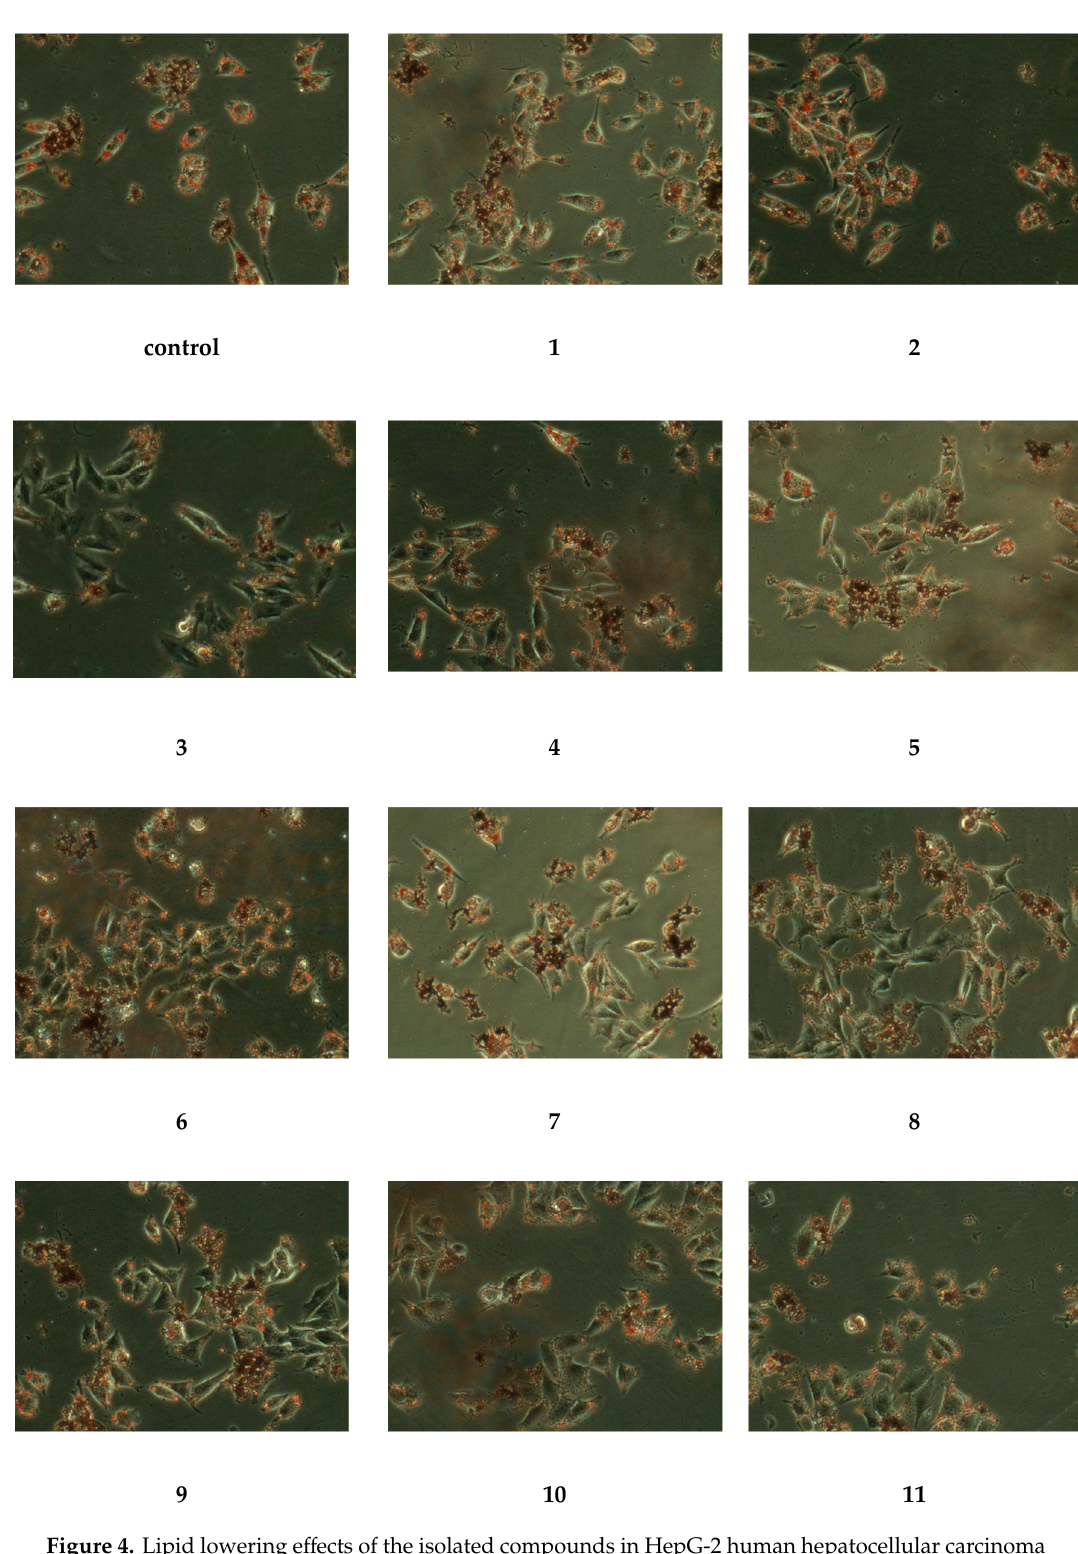
Figure 4. Lipid lowering effects of the isolated compounds in HepG-2 human hepatocellular carcinoma cells. The cells were pretreated with concentration (50 µg/mL) of compounds 1 – 11 for 24 h and then stained with oil red O for 1 h in the dark environment.